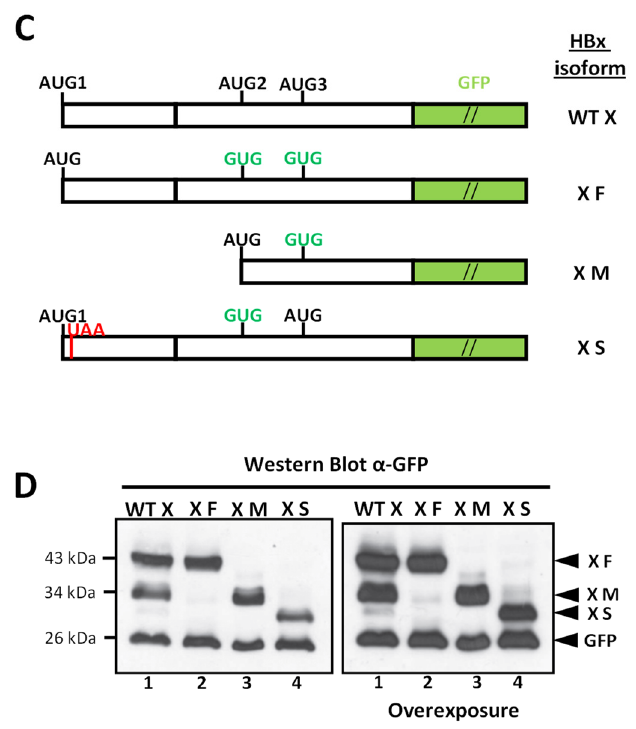
Figure 1. HBx domains organization, smaller isoforms, and their constructs for expression in Huh-7 hepatocarcinoma cells. ( A ) HBx functional domains organization [22–26]. N-terminal negative regulatory domain includes the AUG1 (green), Met1 (bold red), and Ser/Pro-rich region segment (blue). HBx C-terminal transactivation domain with AUG2 (green), Met79 for HBx Medium smaller isoform (XM), including H-box α -helix (blue). AUG3 (green), Met105 for HBx smaller isoform (XS), including the BH3-like motif (blue) are shown. Calculated molecular weight and basal isoelectric point (pI) for each HBx-derived isoform polypeptides are indicated to the right. ( B ) HBx in-frame AUG1, AUG2, and AUG3 initiation codons of HBV genotype F1b (Genebank KM233681.1) [27,28] compared with Kozak consensus sequences. Critical positions ( − 3, and +4) for optimal translation with respect to Kozak consensus are shown in red. ( C ) Scheme of HBx constructs for either canonical or individual HBx isoforms expression fused to the GFP marker. HBx constructs were made with the indicated regions of the HBx reading frame (white blocks), and with the substituted point changes (AUG -> GUG). For HBx XS expression (“mini-HBx”), the complete HBx reading frame was necessary for expression, introducing an in-frame early stop codon to prevent full HBx expression (UAA and red line) and a GUG change in the AUG2 to prevent the expression of XM. ( D ) Expression of the HBx isoforms upon transfection in Huh-7 cells, and Western blot to detect GFP expression. DNA constructs were transfected in Huh-7 cells, cell extracts were resolved by SDS-PAGE, and HBx isoform proteins were detected by Western blot against GFP protein marker. WT HBx (WT X, lane 1), HBx full-length (XF, lane 2), HBx medium-length (XM, lane 3), and HBx small-length (XS, lane 4) are indicated. Right panel is an overexposure of the signal showed to the